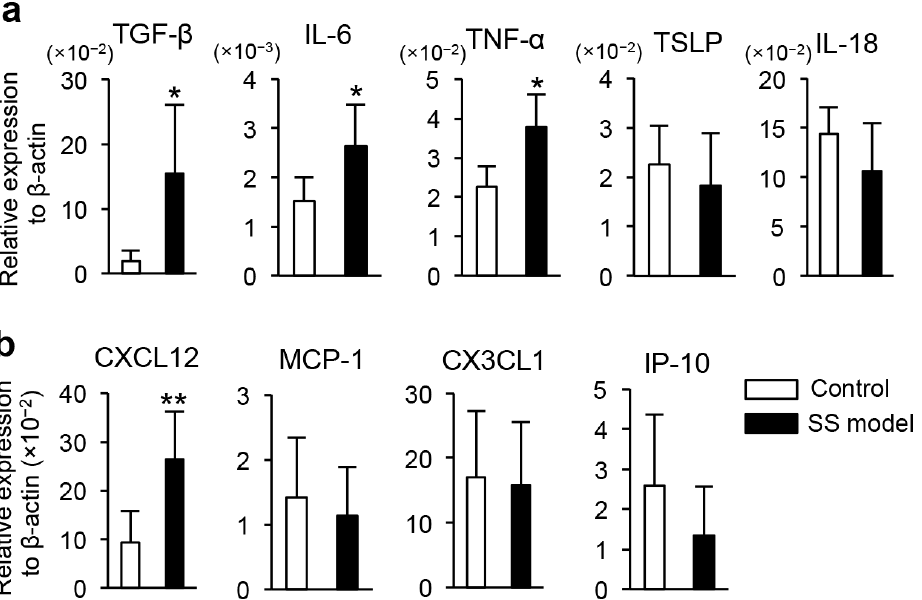
Figure 3. Gene expression in corneal tissues of the SS model mice. ( a ) mRNA expression of cytokines in corneal tissues from the SS model and control mice was determined by real-time reverse transcription-polymerase chain reaction (RT-PCR); and ( b ) mRNA expression of chemokines in the corneal tissues was determined by real-time RT-PCR. Data are means ± SD of six mice in each group. * p < 0.05, ** p < 0.01.